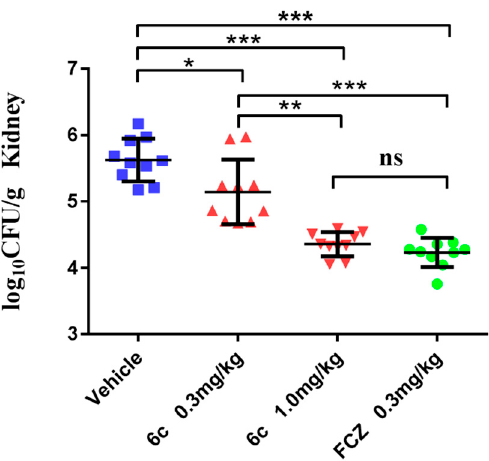
Figure 5. Effects of the antifungal treatments on the tissue burden. Each mouse was intravenously infected with C. albicans SC5314 5 × 10 6 . Saline, FCZ (fluconazole, 0.3 mg/kg), compound 6c (0.3 mg/kg and 1.0 mg/kg) were administered orally once daily for 3 days after infection. Kidneys of mice were harvested on day 4 and colony-forming units were measured. * p < 0.05, ** p < 0.01, *** p < 0.001, determined by ANOVA.